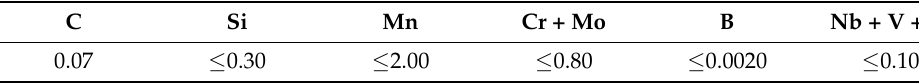
Figure 1. Metallographic diagram of 700L material. Table 1. Chemical composition of 700L material (wt%).